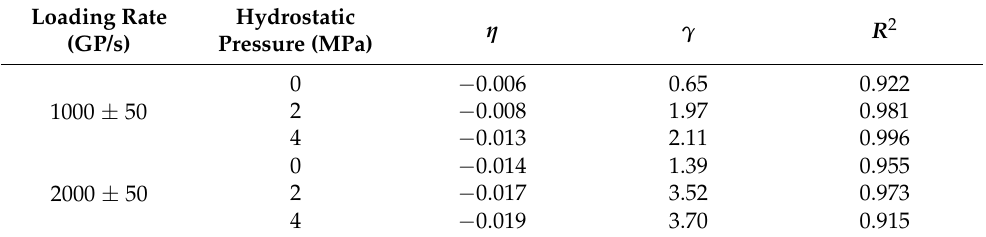
Table 3. Fitting parameters ( η , γ ) and coefficient of determination ( R 2 ).